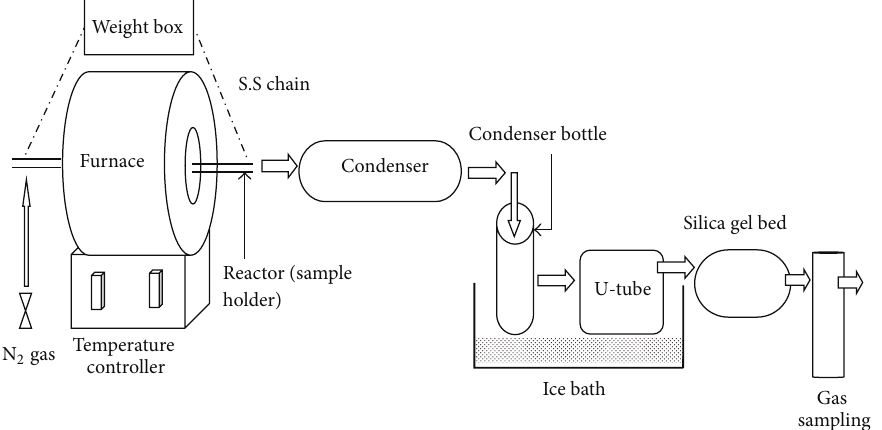
Figure 2: Experimental set up.